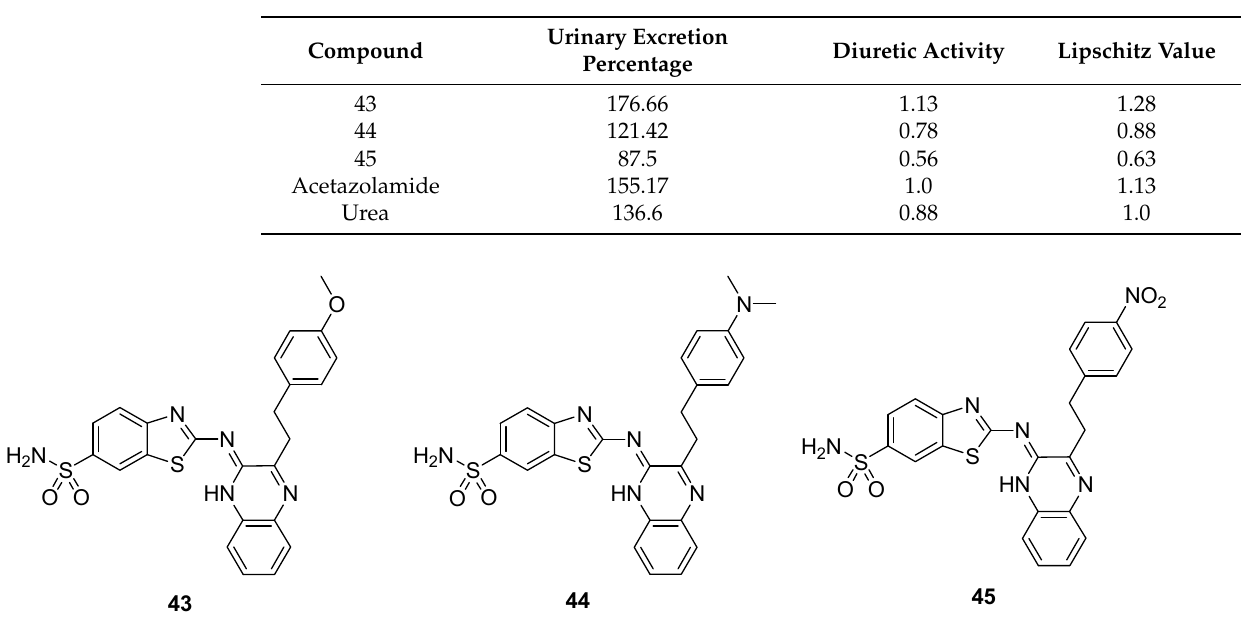
Figure 7. Substituted quinoxaline benzothiazole sulfonamide derivative 43–45.